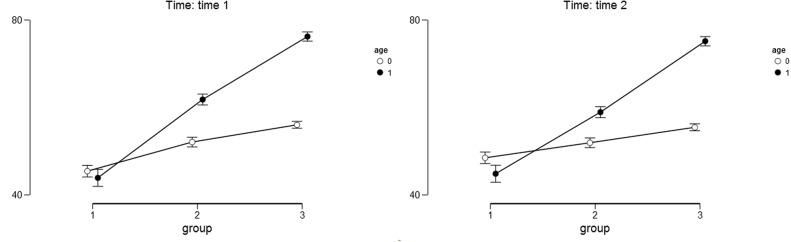
Descriptive statistics for the stress-related growth as the outcome variable. Age – 0 stands for younger children and 1 stands for older children. Group – 1 stands for control group; 2 stands for placebo group; 3 stands for narrative group. Error bars represent the 95% CI of a mean.